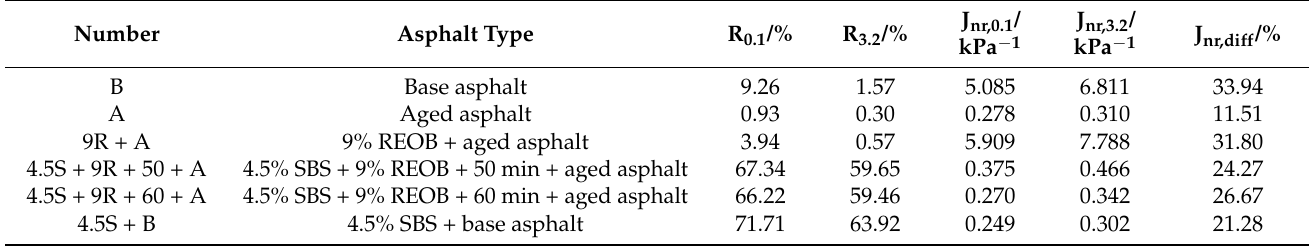
Table 7. Calculated results of MSCR tests for each asphalt at different stress